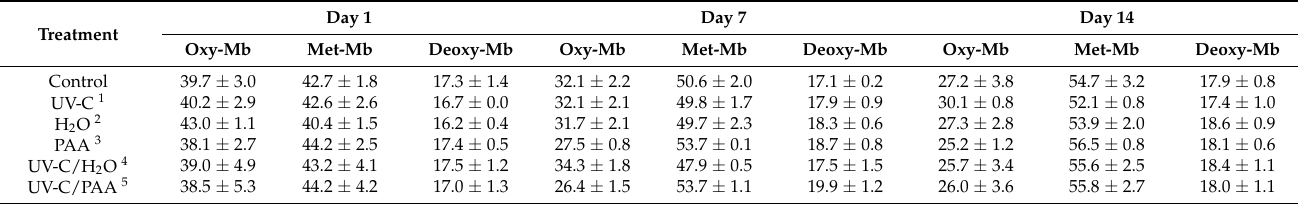
Table 7. LSM ± SE of the Oxy-myoglobin (Oxy-Mb), Met-myoglobin (Met-Mb), and Deoxy-Myoglobin (Deoxy-Mb) percentages of pork after UV-C, peracetic acid (PAA), and H 2 O treatments alone and in combination after 1, 7, and 14 days of storage ( n = 3).